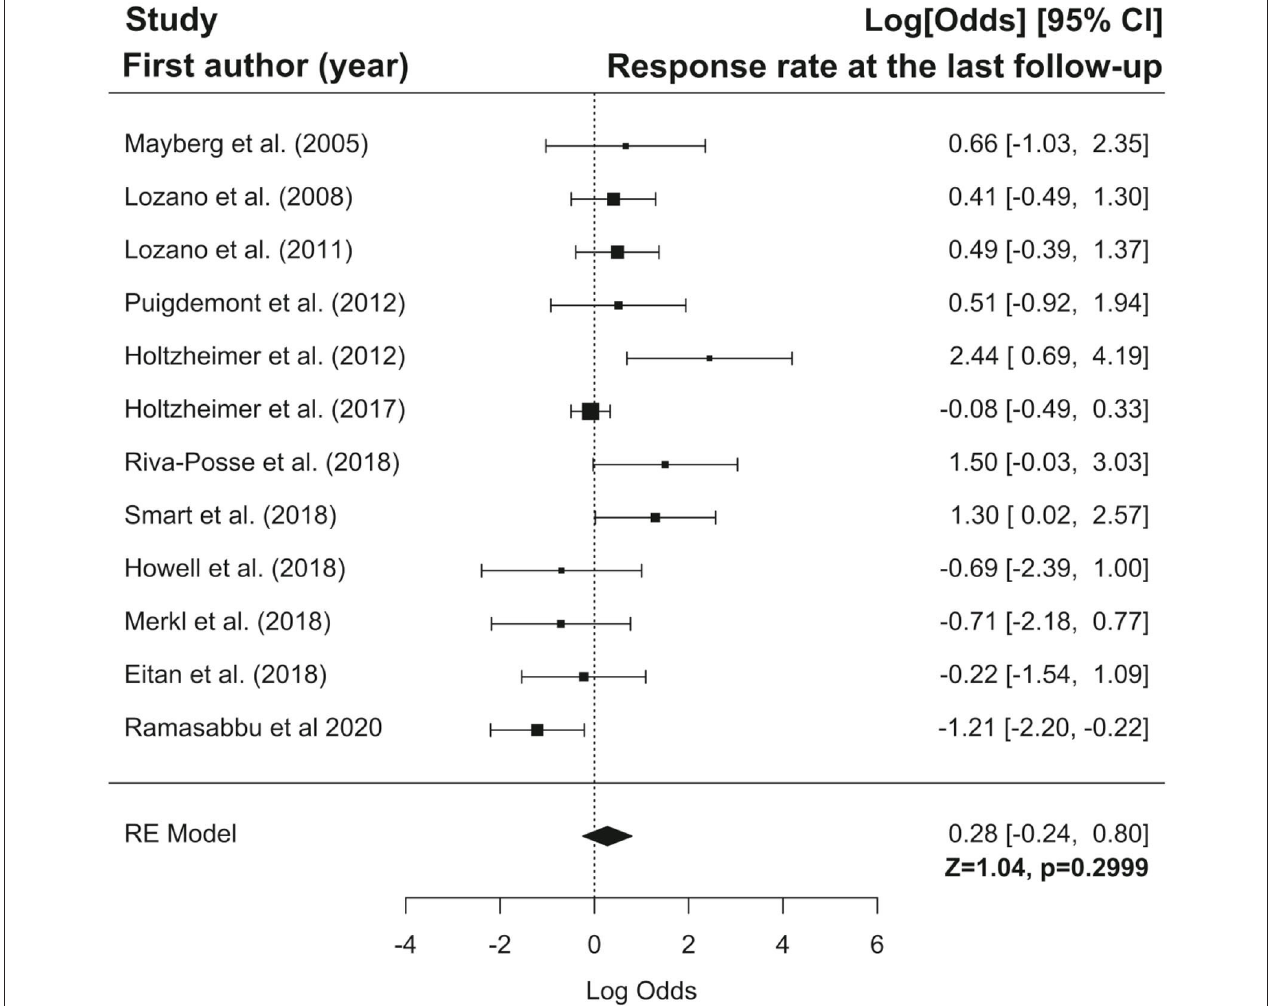
FIGURE 3 | Forest plot showing logit-transformed proportions for response rate at the last follow-up.